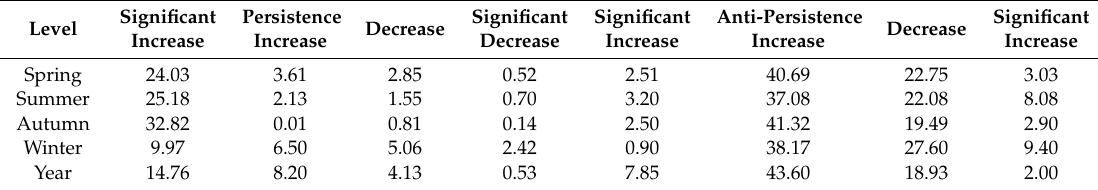
Table 3. Persistence statistics of NDVI annual and seasonal scale variation trends in the future (unit: %). Significant Persistence Significant Level Decrease Increase Increase